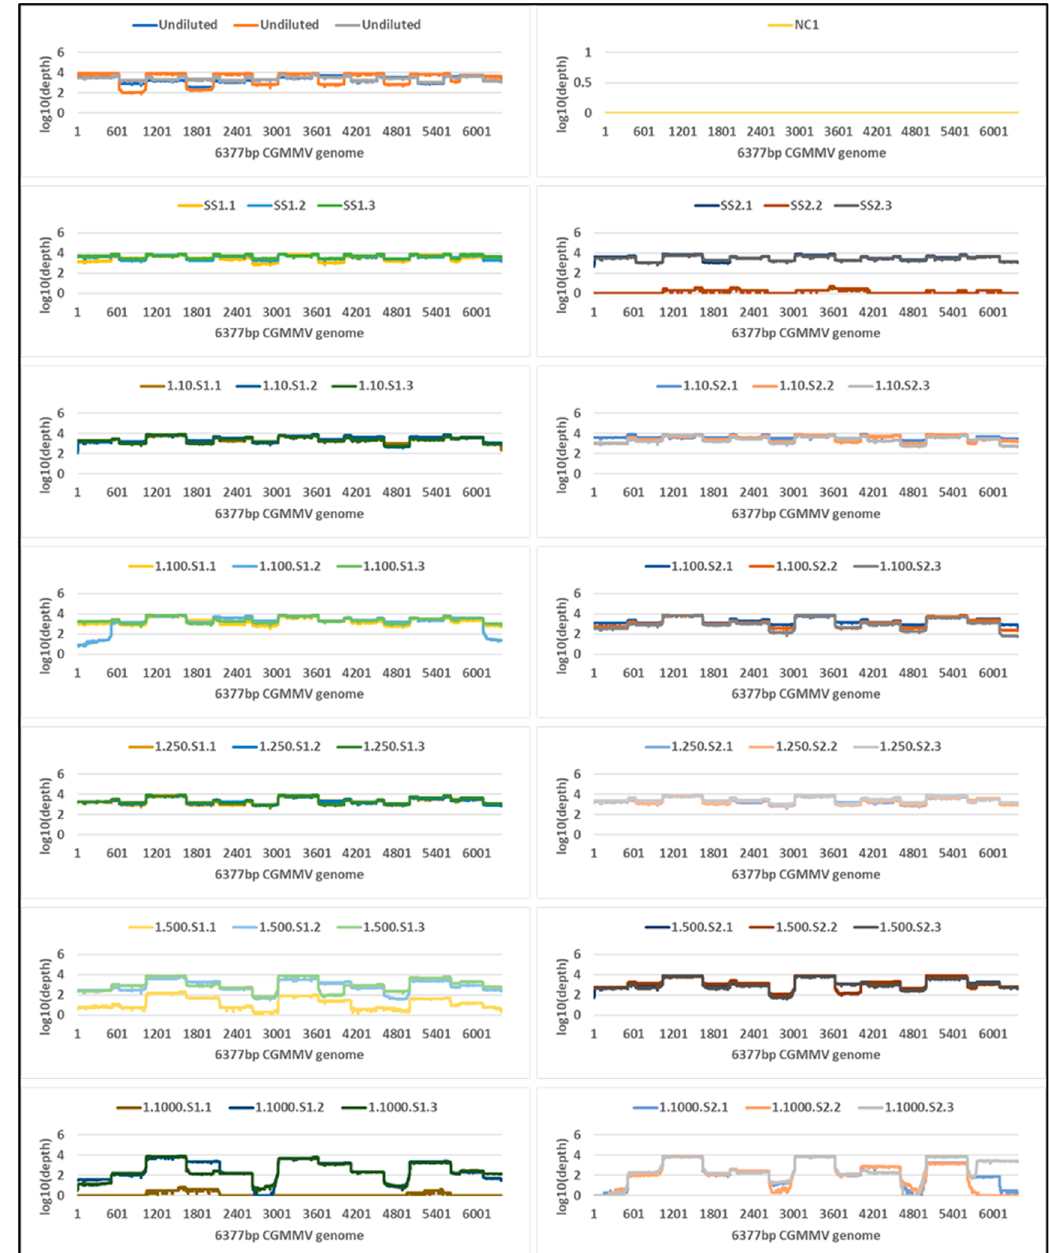
Figure 3. Genome coverage and read depth profiles of seed panel dilution series samples, from undiluted to 1 seed in 1000 across the 6377 nt reference cucumber green mottle mosaic virus (CGMMV) genome (NSW3-35) detected using tiled amplicon nanopore sequencing. Biological replicates are shown in each profile. Each biological replicate was tested in triplicate and the results for each technical replicate are shown as different colours. Depth is in standard logarithmic scale.